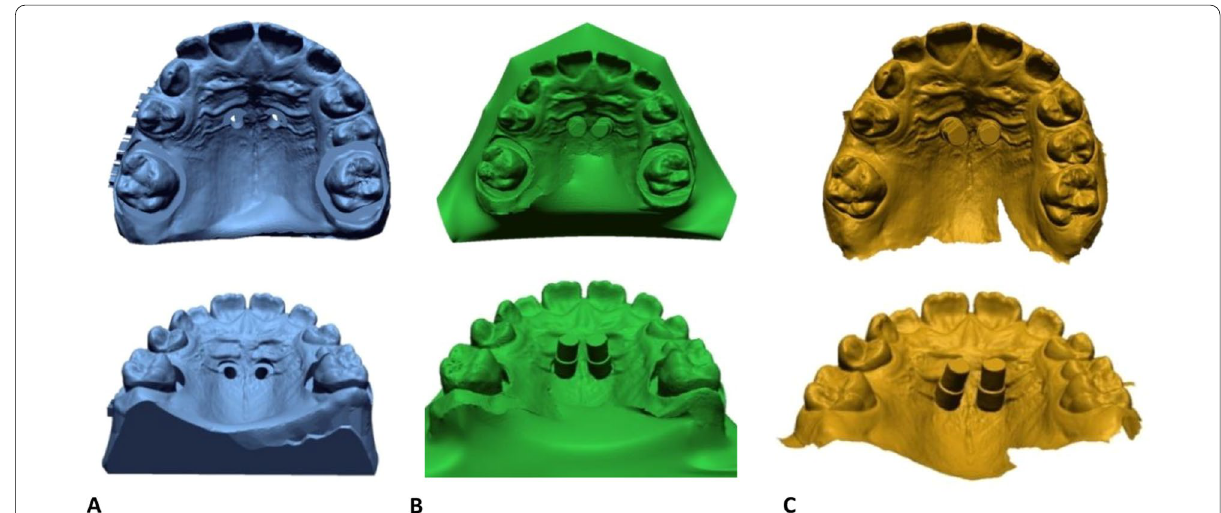
Fig. 2 The three files in STL format were analyzed with Geomagic Design X software (Geomagic Design X- version 2019.0.2). A digital planning of the miniscrews’ position (blue); B scanning of the 3D model with scan bodies for the design and fitting of the orthodontic device (green); C post-insertion digital impression with scan bodies